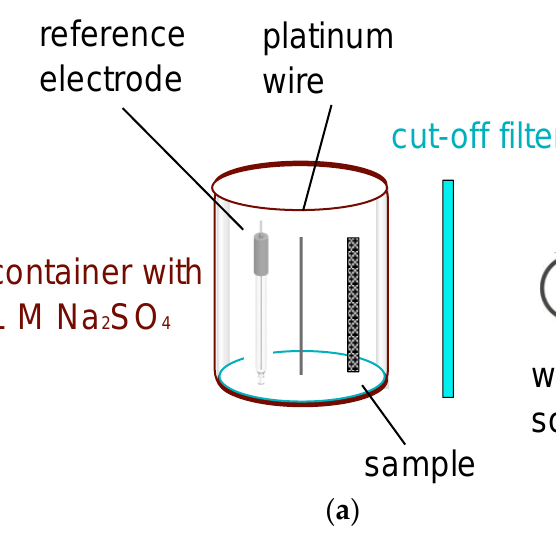
Figure 1. ( a ) Schematics of the 3-electrode setup. ( b ) Image of 3-electrode experimental setup. A white-light source illuminates the sample through a color (here, blue) filter. The electrode was immersed in an electrolyte (1 M Na 2 SO 4 ) and a comparison was made between the illuminated and non-illuminated cases. The Metrohm measurement system (white box) is shown in the back, in front of the lab notebook.